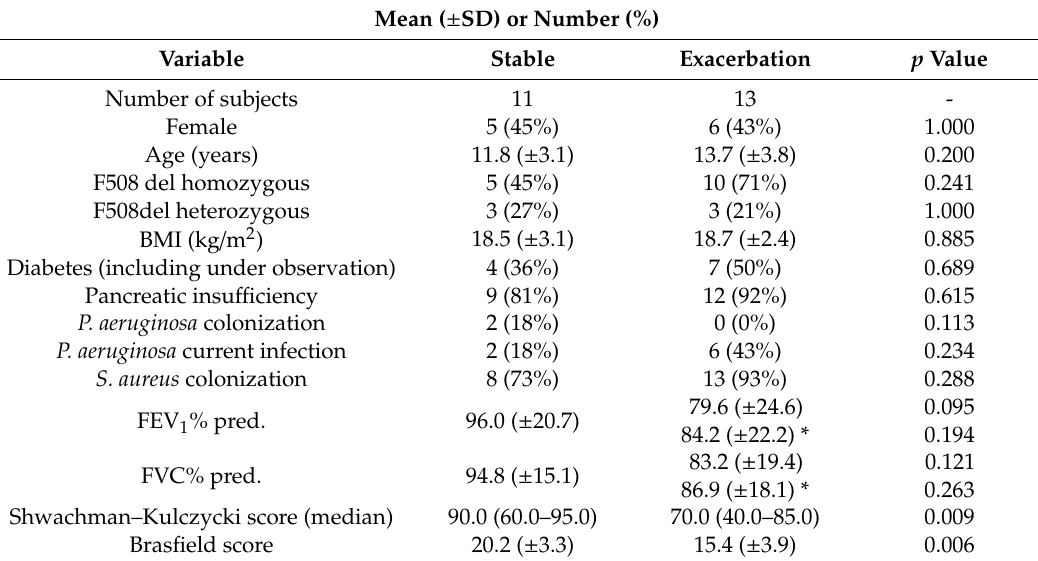
Table 2. Characteristics of the CF patients (sputum